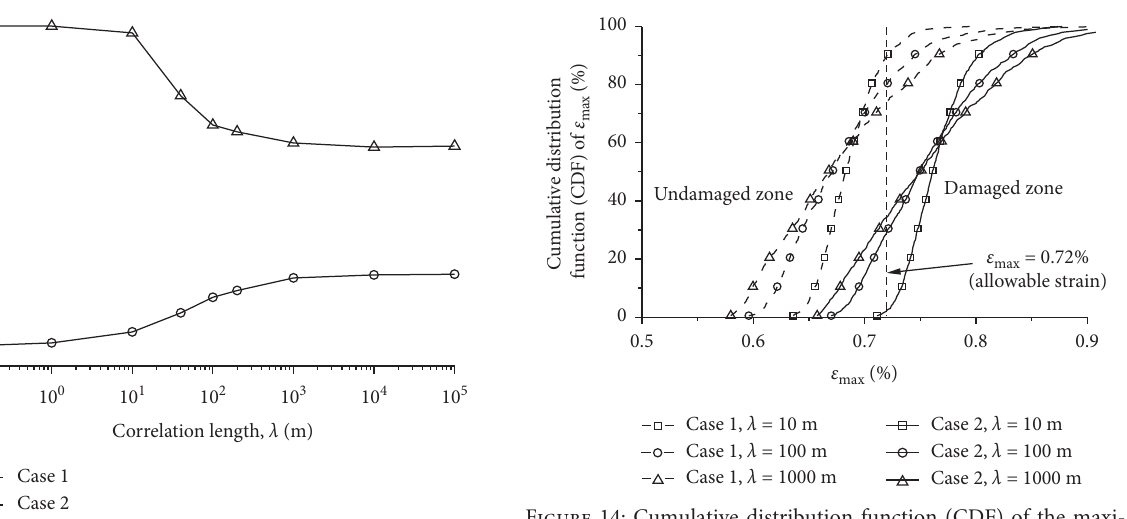
Figure 13: Effect of spatial variability on the cable damage probability.